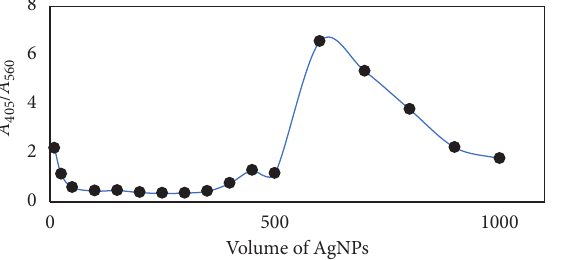
Figure 6: Effect of the volume of AgNPs on the response of the sensor; experimental conditions: 5.0 × 10 − 4 M of zidovudine, pH 8.0 in HCl/ NaOH solution, and response time of 15 min.